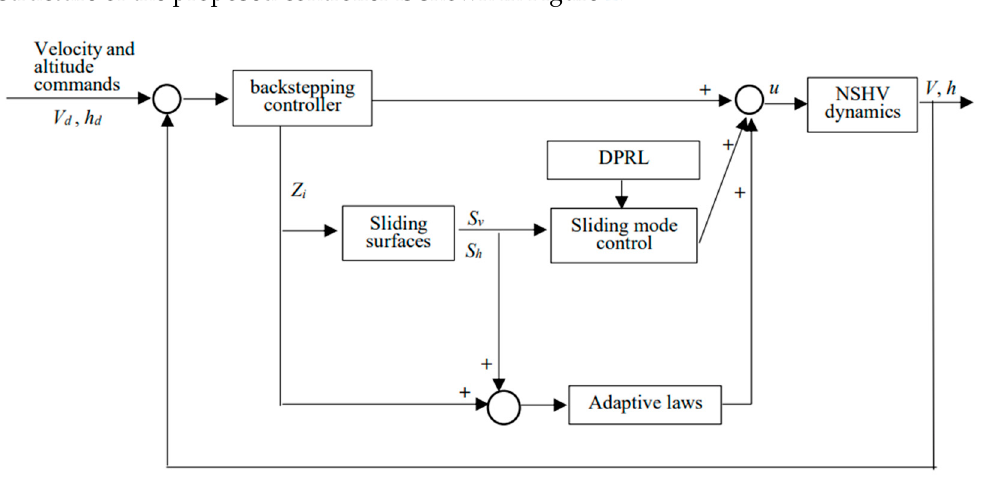
Figure 2. The system structure of sliding mode backstepping controller using